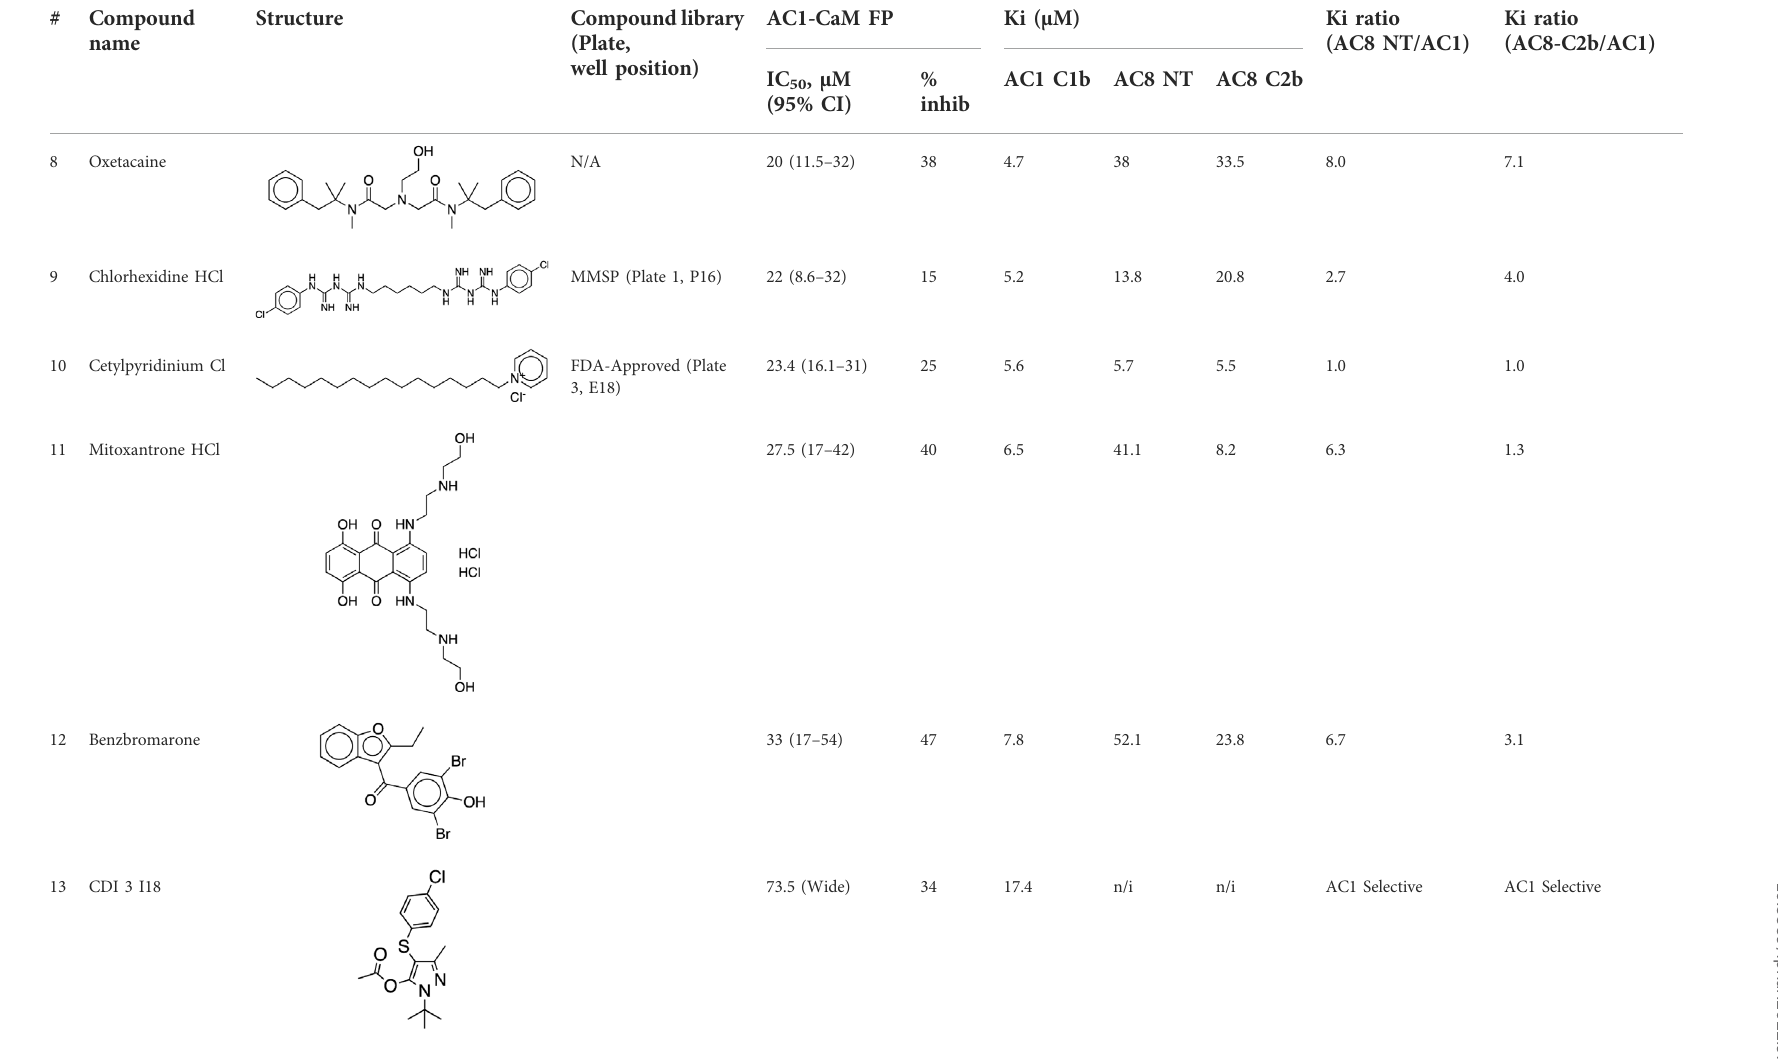
TABLE 3 ( Continued ) AC1/CaM pilot screen CRC analysis. IC 50 and % inhibition relative to 100 μ M CDZ (100% inhibition) obtained for each compound in the AC1/CaM FP assay. The Ki values obtained with experimentally determined K D values for each AC/CaM FP assay and the IC 50 values obtained for each compound in the designated AC/CaM FP assay. The fi nal two columns show the K i ratios obtained for either AC8-Nt/CaM or AC8-C2b/CaM over AC1/CaM. Values with K i ratios greater than 1 were more potent in the AC1/CaM FP assay over the designated AC8/CaM FP assay. All data represents n = 3 experiments, ± CI for AC1/CaM IC 50